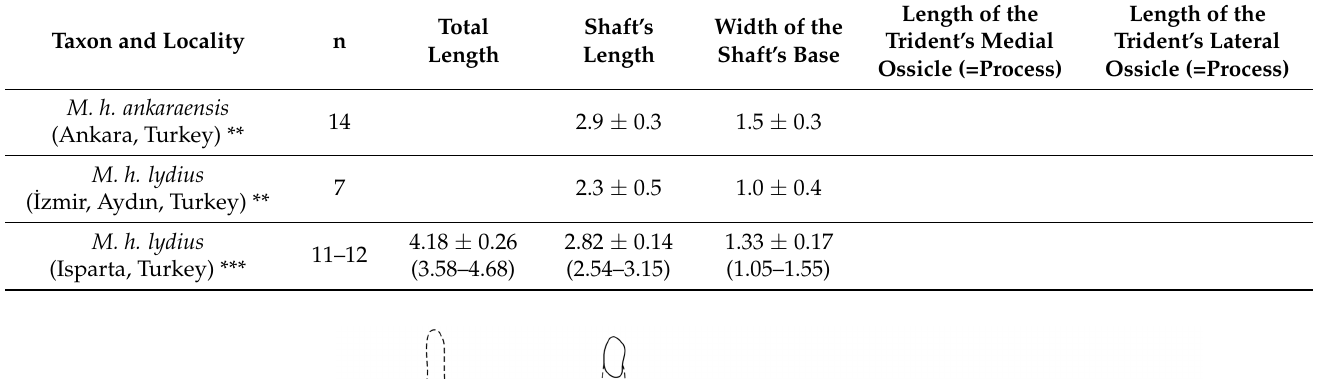
Figure 5. 3D models of the hemimandibles and lower molars (m1, m2, m3) of M. h. ankaraensis (ZIN 98971; A ) and M. hartingi (ZIN 107168-10 from the Eastern Rhodopes; B ). ( A1 , B1 ) Models of the right hemimandibles in medial view. ( A2 , B2 ) Models of the dentary part in transparent view showing molars’ positions. ( A3 , B3 ) Models of isolated molars in medial view. ( A4 , B4 ) Models of lower mo- lars in occlusal view. ( B5 ) An X-ray image of the first molar in parasagittal cut view. Abbreviations. a: the red line shows the approximate border between “normal” prismatic structure of the crown and an “abnormal” part of the crown that lost prismatic structure; b: the red dotted line indicates Table 3. Cont. the part without prisms. The scale bar is 5 mm. Length of the Length of the Trident’s Lateral Trident’s Medial Ossicle (=Process) Ossicle (=Process)